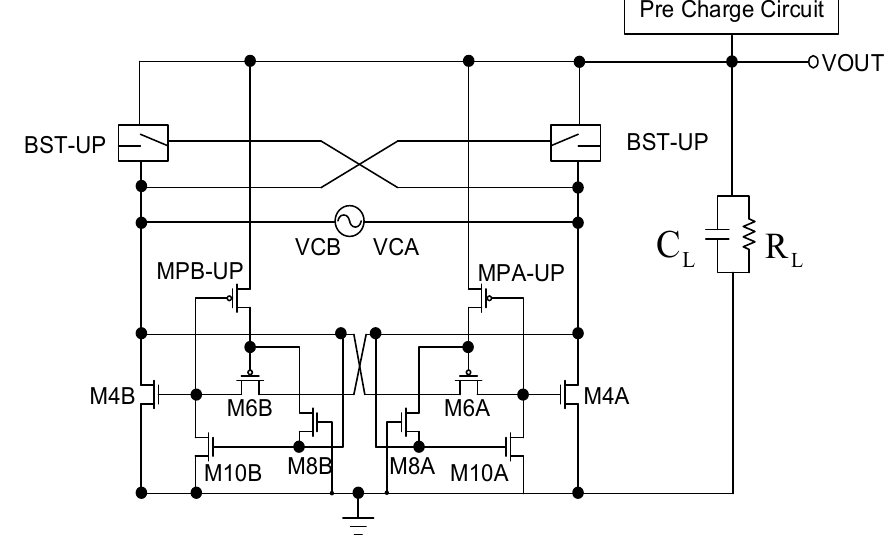
Figure 13. Bootstrap circuit diagram (proposed